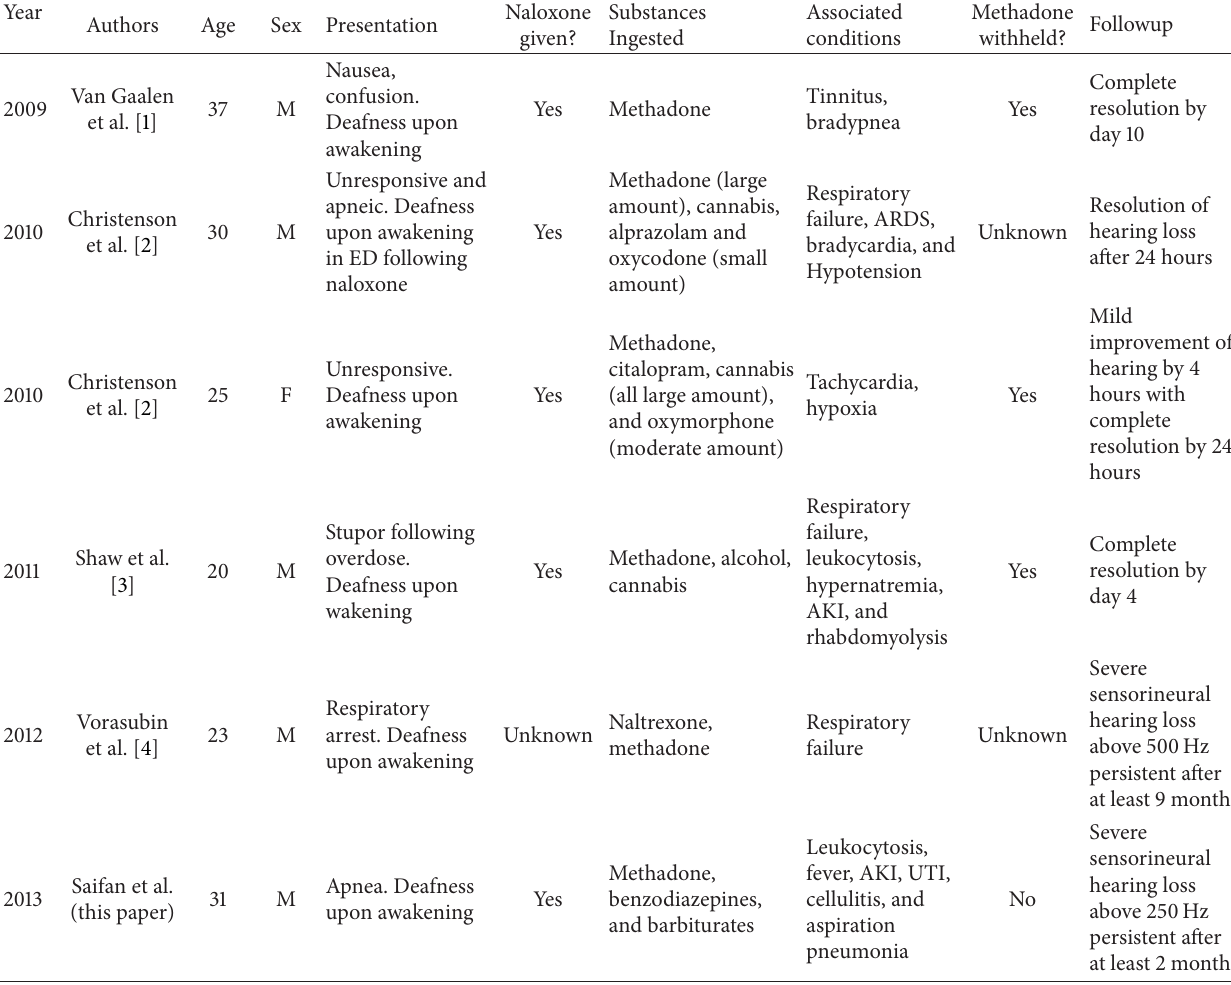
Table 1: Review of published cases of methadone induced hearing